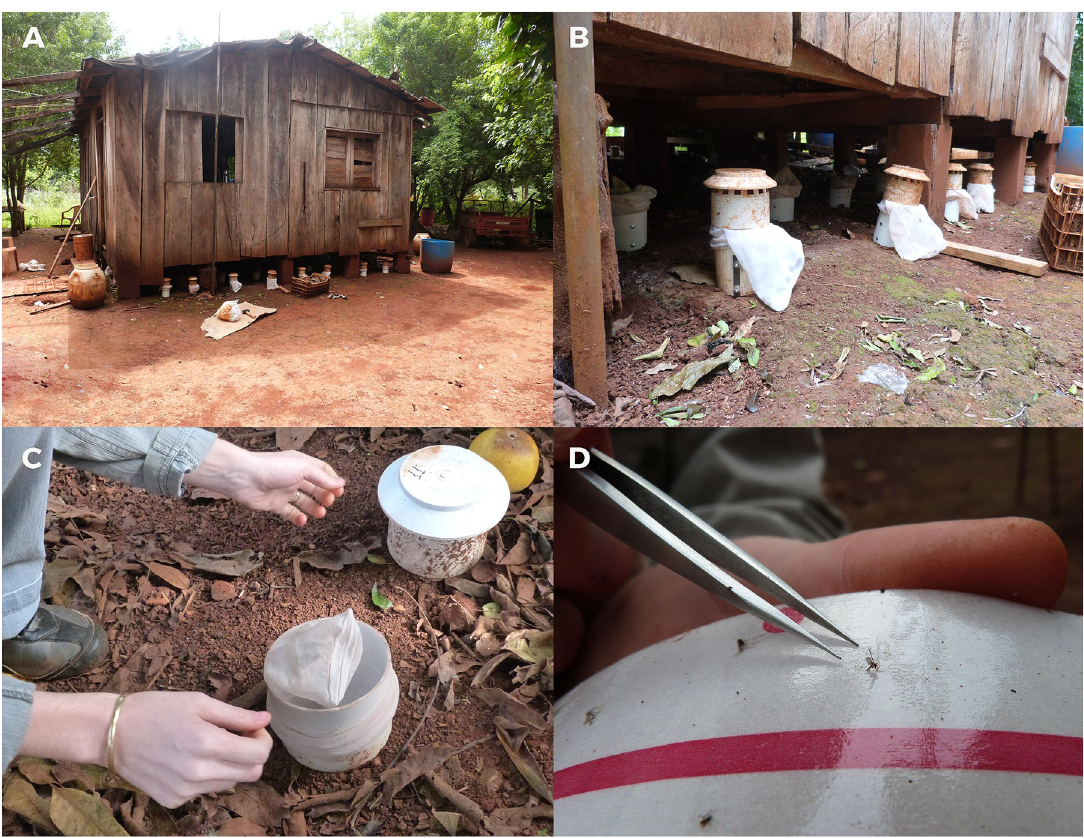
Fig 1. Emergence traps. A: Emergence traps fixed under a house. B: Emergent trap fixed to the ground using steel flat bars attached and PVC vent cap attached to each tap to protect. C: Covering the emergence trap with a sand fly-proof fine mesh to prevent sand flies escaping. D: A new emergent adult phlebotomine removed directly of adhesive paper with entomological